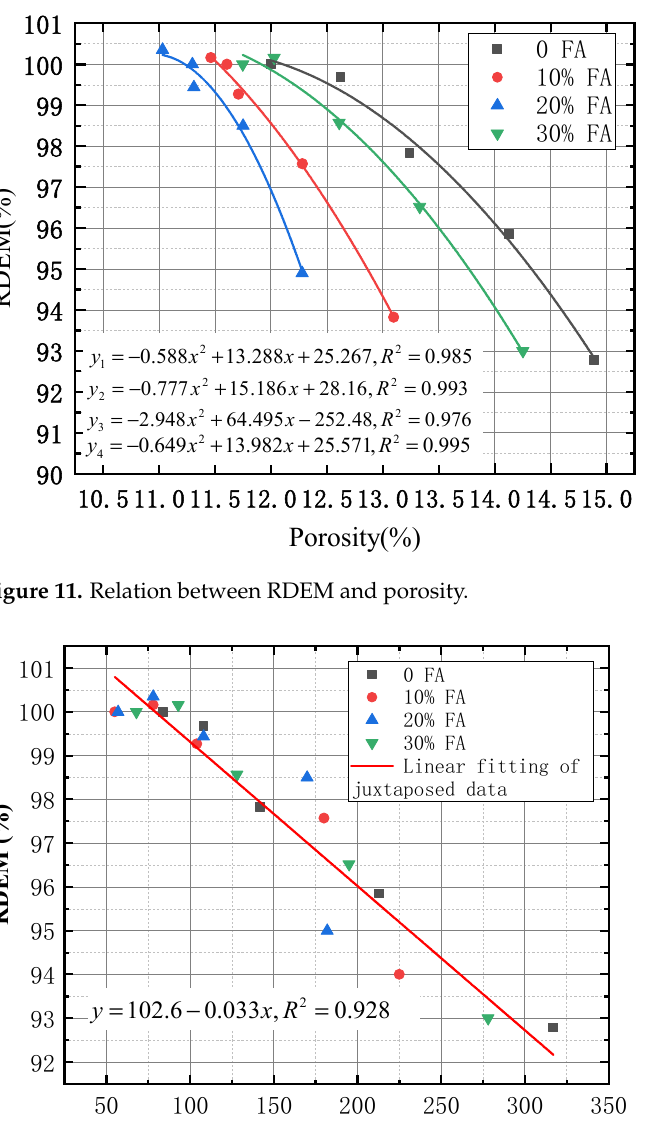
Figure 13. Relationship between splitting tensile strength and porosity. The relationship between the splitting tensile strength of concrete blocks with differ- ent FA contents and the most probable pore size is shown in Figure 14. The figure illus- trates that the relationship between the splitting strength and the most probable pore size is linear and negative in the FTC process. The splitting tensile strength decreases with the increase in the most probable pore size, which is due to the increase in internal mi- crocracks and capillary pores after repeated FTC. Concrete microstructure distribution is affected by these pores and pore water migration is accelerated by them. Water becomes